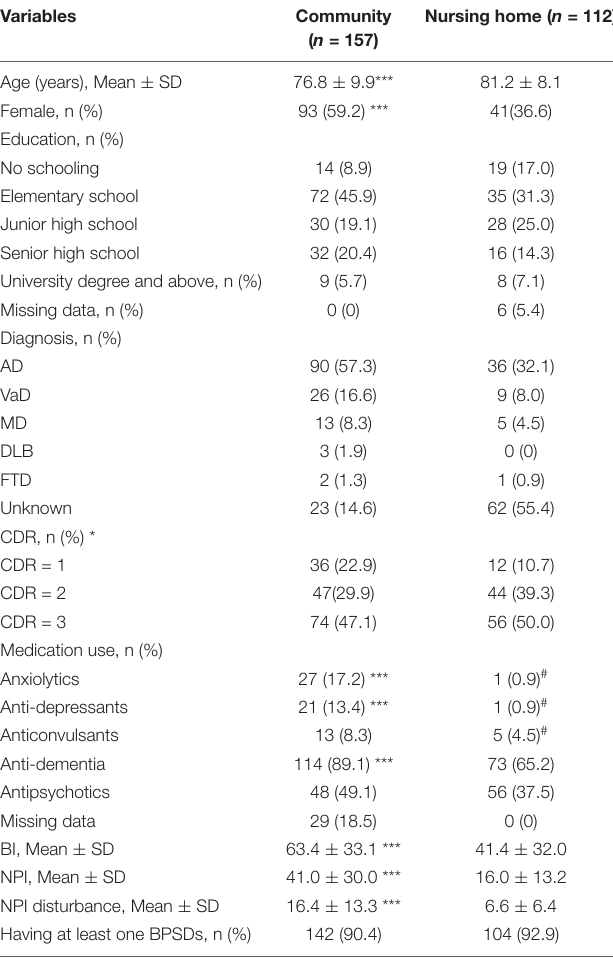
TABLE 1 | Demographic and clinical characteristics of the